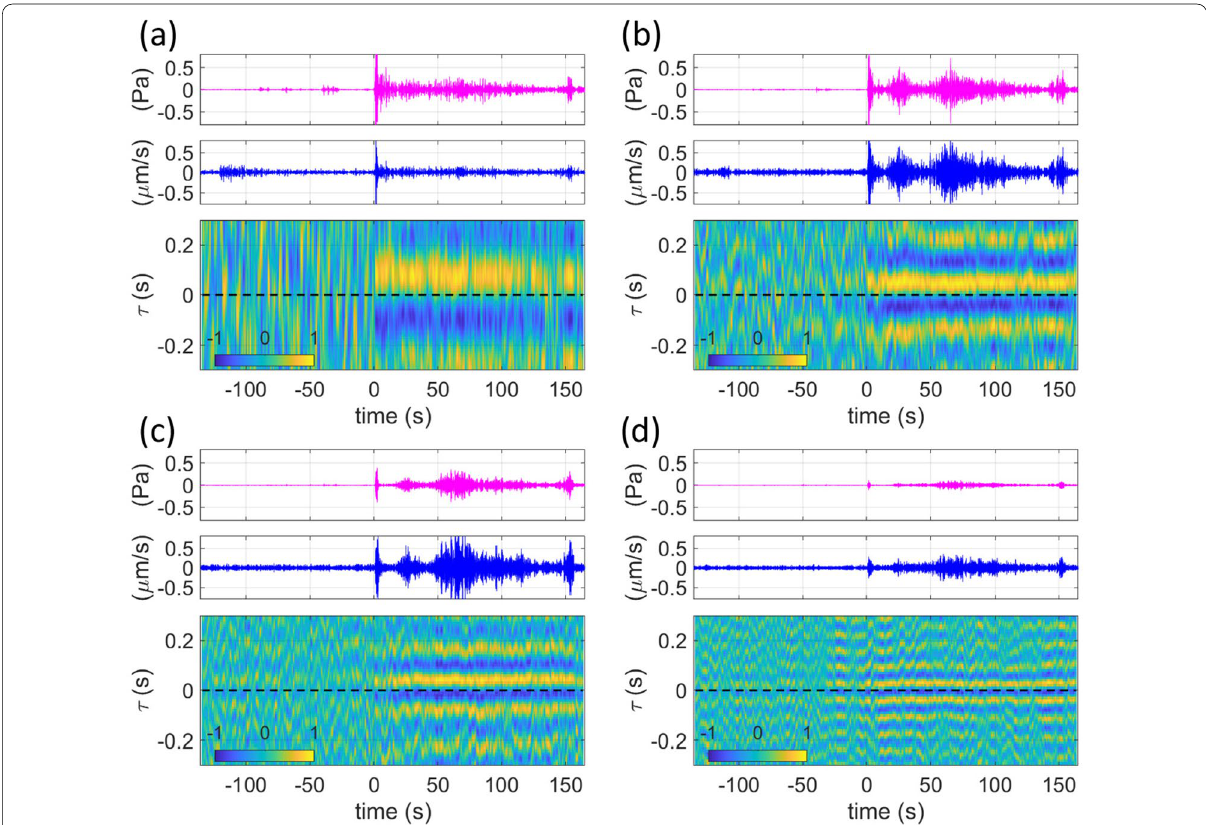
Fig. 2 Cross-correlation analyses of the data in Fig. 1 at a 1–3.5 Hz, b 3.5–7 Hz, c 7–12 Hz, and d 12–18 Hz. In each panel, the top and middle frames show the band-passed infrasonic data ( d p ) and seismic data ( d v ), respectively. The bottom frame shows the cross-correlation coefficient between the seismic data, d v , and infrasonic data, d p , with the vertical axis representing the time delay, τ , of d v to d p . The horizontal dashed line